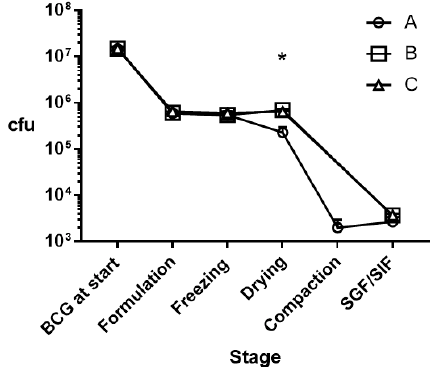
Figure 3. Cumulative reduction in BCG viability (cfu) for each matrix formulation (A, B, C) through each stage. BCG–Eudragit matrix composition: ( A ) Eudragit L100 / 2 mL PBS / 0.9 mL Tween ® 80 (0.1% w / v ); ( B ) same as (A) plus mannitol (0.2% w / v ); ( C ) same as (A) plus trehalose (0.2% w / v ). * p < 0.05 for